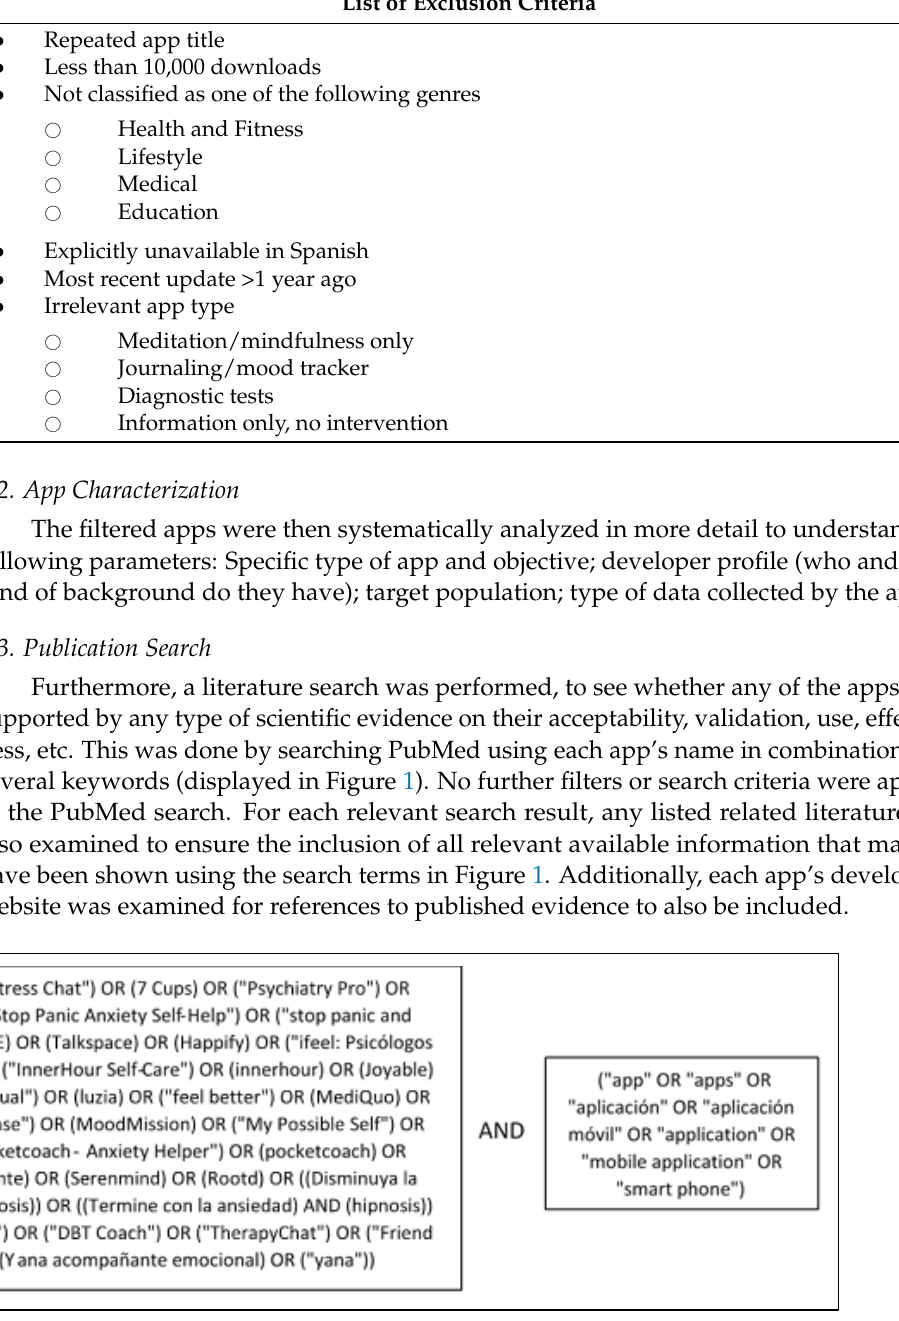
Figure 1. Search terms used for publication search of resultant apps.